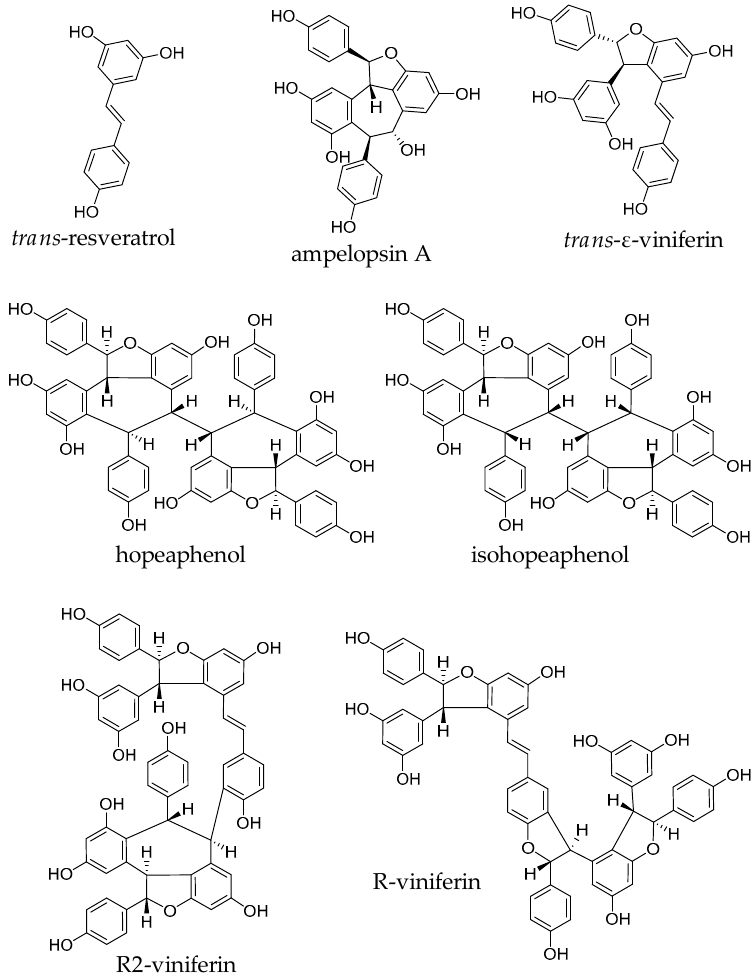
Figure 1. Chemical structures of resveratrol and resveratrol oligomers.